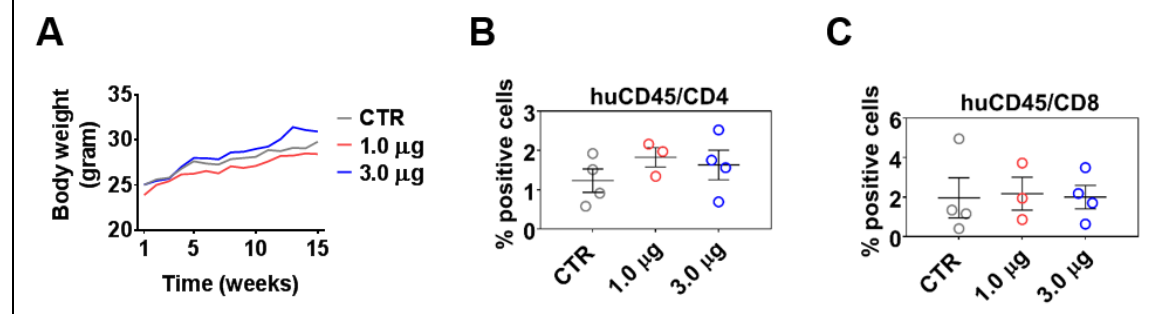
Figure 6. Administration of LV-DR4/fLuc vector into huNRG is safe and shows a trend towards increased CD4 + T cell frequencies. ( A ) Weight monitoring of huNRG mice for each cohort after LV-DR4/fLuc administration; ( B , C ) terminal analyses of the frequencies of CD4 + and CD8 + T cells in the spleen by flow cytometry. No significant effects were observed in these dose-finding experiments.